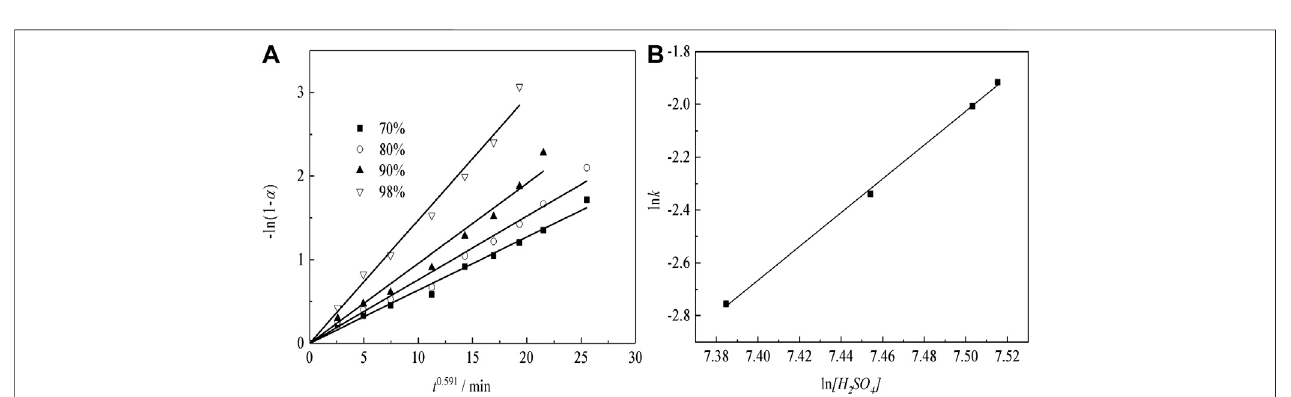
FIGURE 13 | Transformation ratio of Nd and kinetic analysis with various H 2 SO 4 concentrations.